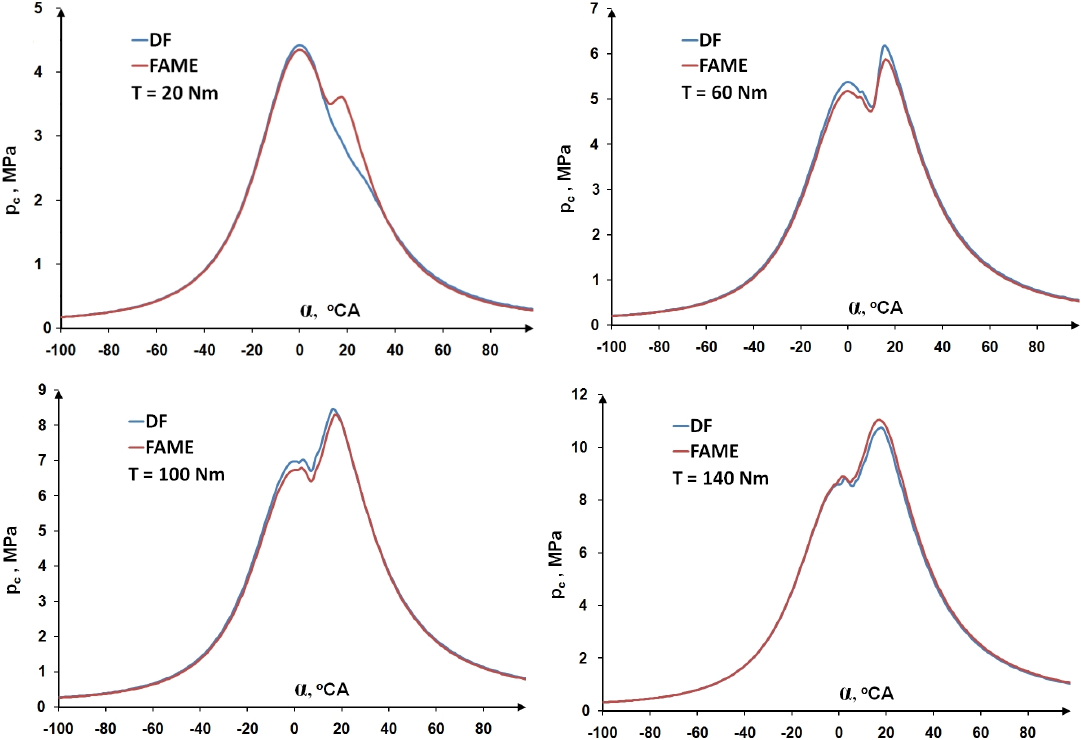
Figure 2: Comparison of pressure waveforms during the combustion process in the Fiat 1.3 MultiJet engine cylinder supplied with the following fuels: FAME, DF, operating according to the load characteristics for n = 1750 rpm, with loads T = 20, 60, 100 and 140 Nm